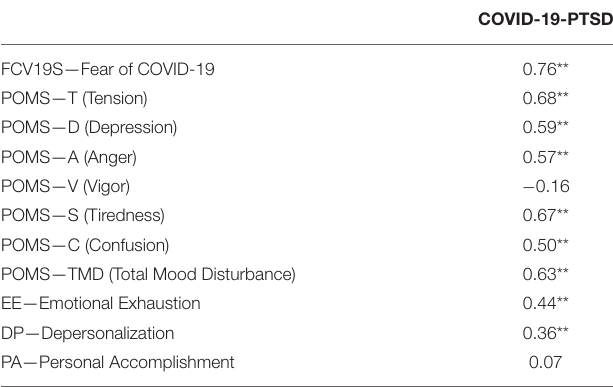
TABLE 3 | Pearson correlation of COVID-19—Posttraumatic Stress Disorder (PTSD) with Fear of COVID-19 scale (FCV19S), POMS—TMD and subscale, and MBI-HSS scores.